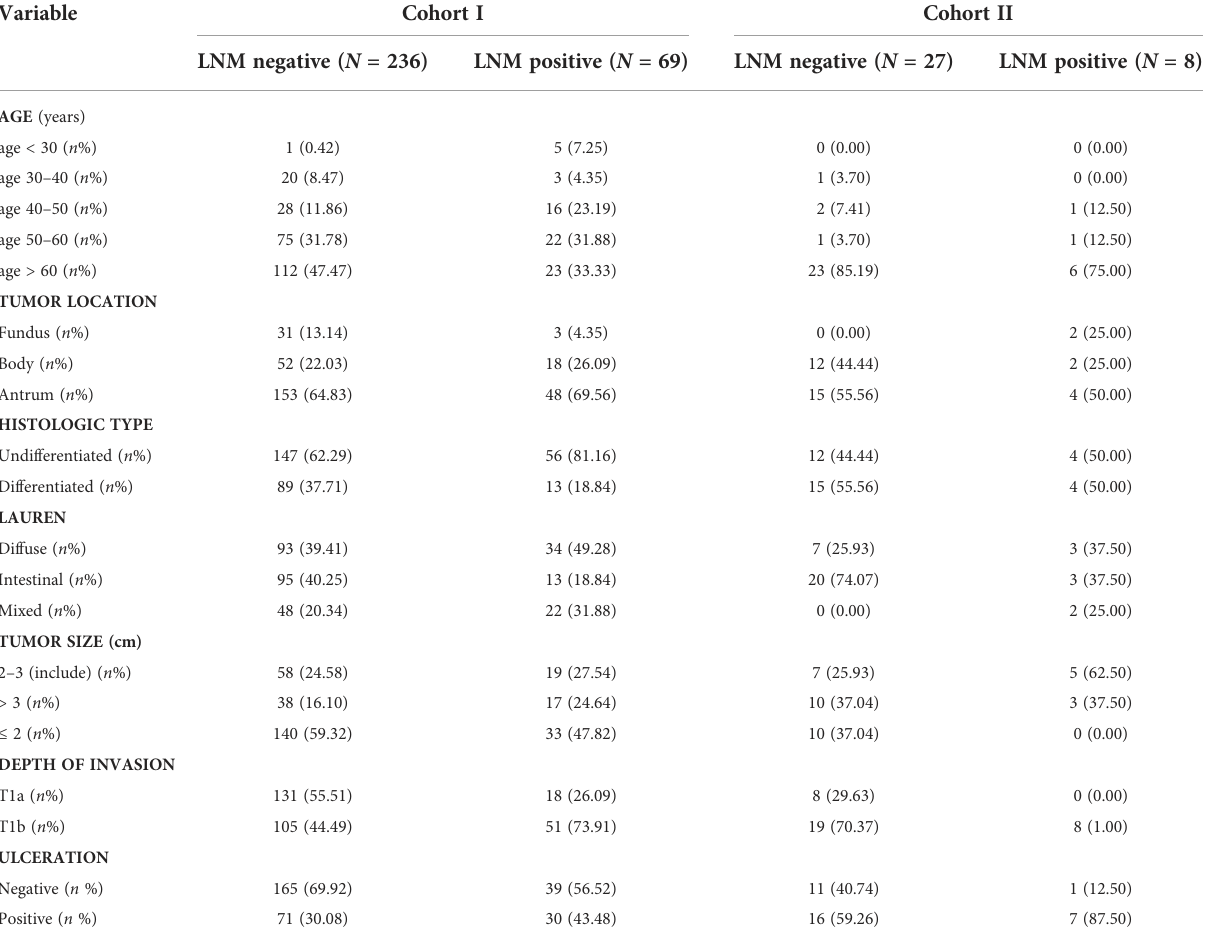
TABLE 2 Clinicopathologic characteristics for established the prediction model between cohort I and cohort